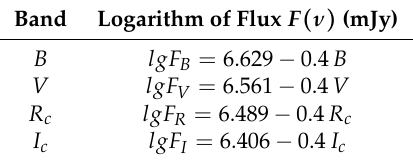
Table 2. Calibration formulae for filters B , V , R c , I c